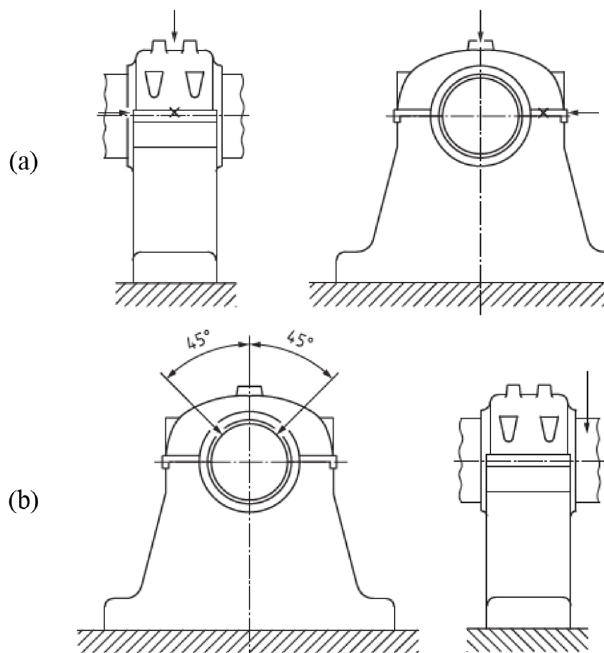
Fig. 3. Sensors ’ location for absolute bearing housing vibration (a) and for relative shaft vibration (b) according to ISO20816- 5:2018 latest standard [7].